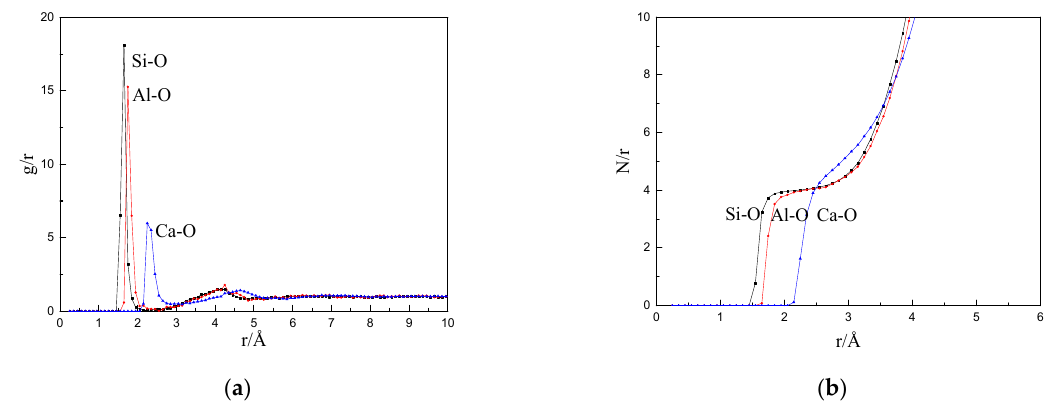
Figure 8. ThesimulationresultsofCaF 2 contentat9%( a )radialdistributionfunctionand( b )coordination Figure 8. The s imulation results of CaF 2 content at 9% ( a ) radial distribution function and ( b ) number function. coordination number function.